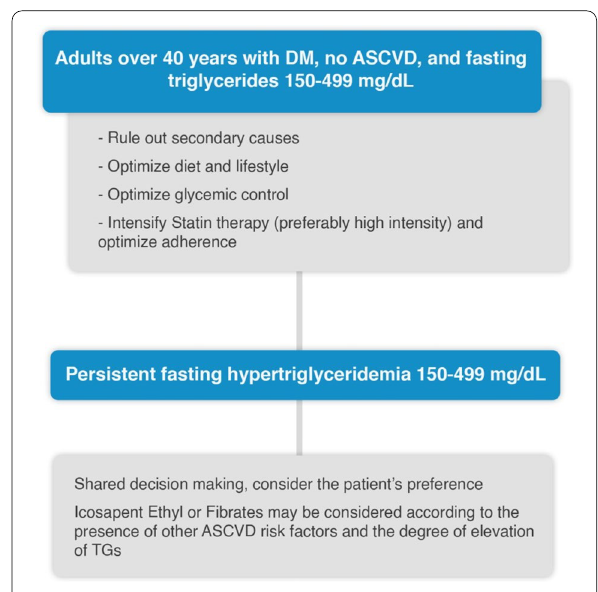
Fig. 4 Management of HTG in diabetic patients without ASCVD